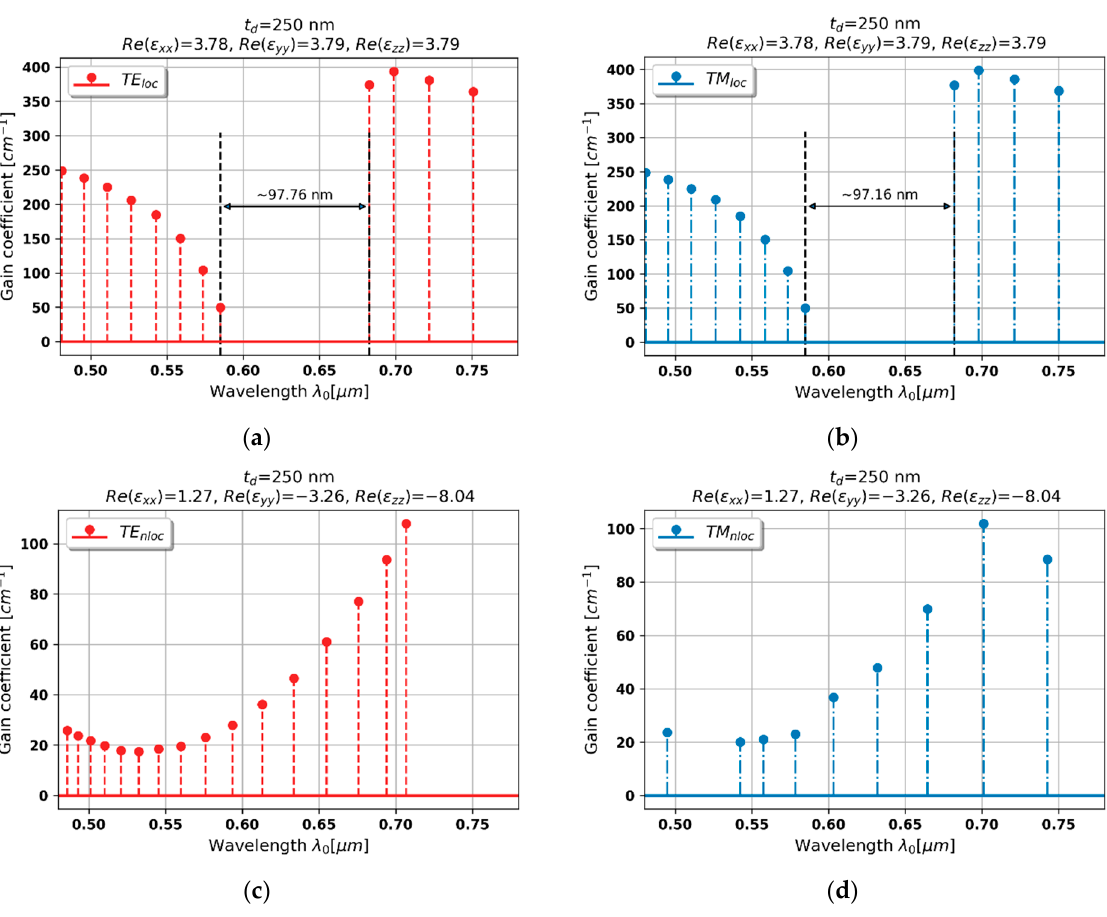
Figure 9. Modal spectra for TE ( a , c ) and TM-polarized light ( b , d ) for a PHC laser based on hyperbolic medium with t ZnO = 250 nm dielectric layer (black double-headed arrow denotes spectral width of stop band of the spectrum).